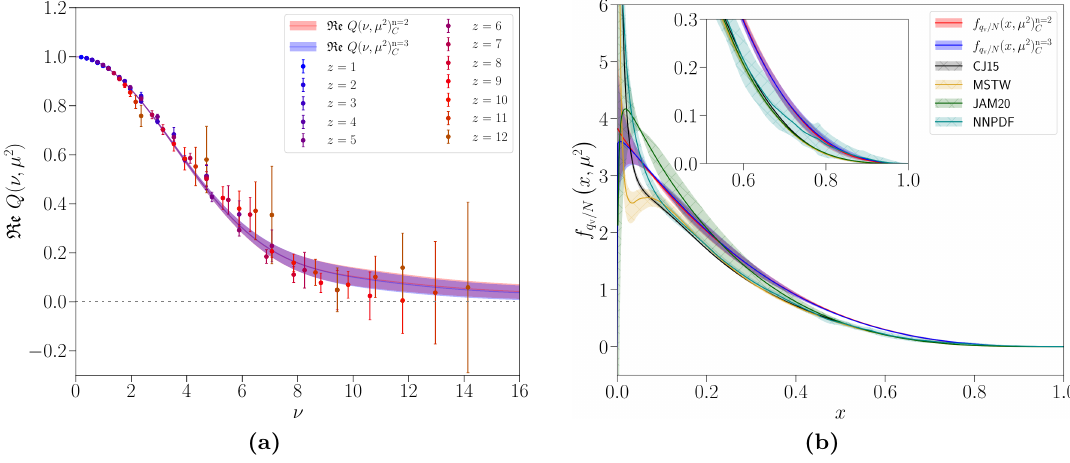
Figure 8. (a) The real component of the matched ITD at µ = 2 GeV in MS fit by cosine transforms of two- and three-parameter model PDFs (4.9). Data has been fit for z/a ≤ 12 , and correlations have been neglected. The resulting PDF parameters and figure of merit are gathered in table 2. (b) The nucleon unpolarized valence quark PDF at 2 GeV in MS determined from the uncorrelated cosine transform fits (4.9) applied to real component of the matched ITD. Comparisons are made with the NLO global analyses of CJ15 [82] and JAM20 [88], and the NNLO analyses of MSTW [89] and NNPDF [87] at the same